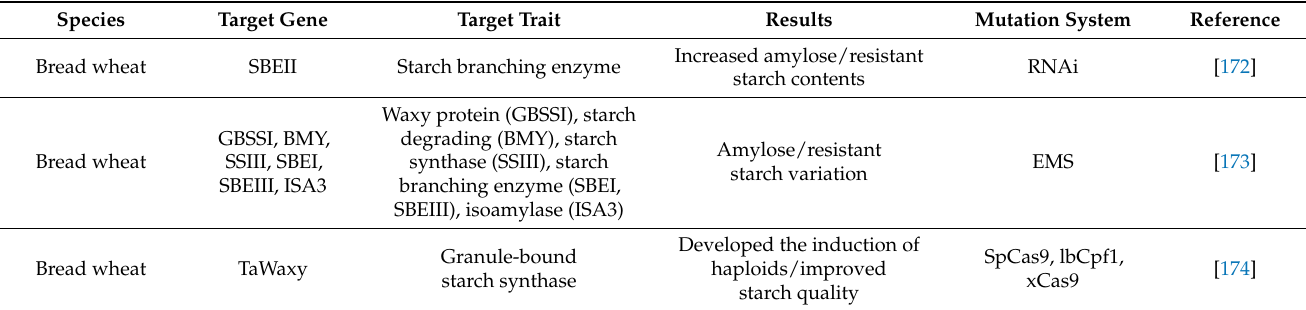
Table 3. Recent status of wheat biotechnology research using characteristics of wheat starch.